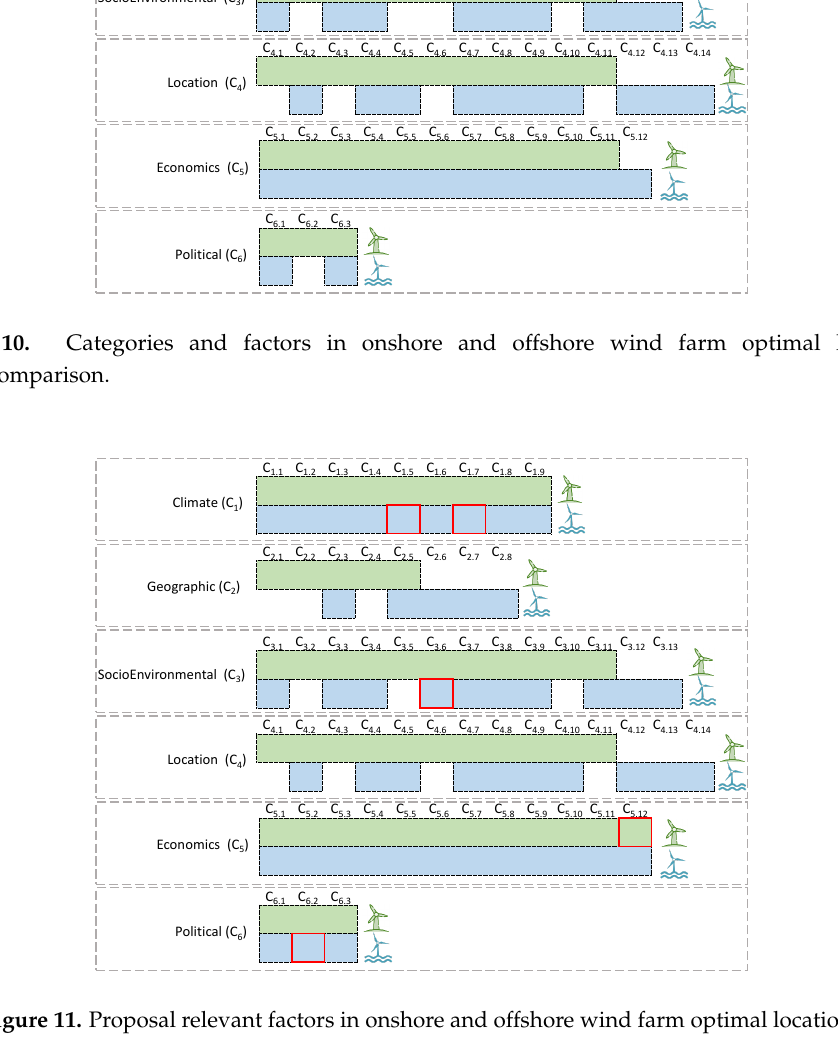
Figure 11. Proposal relevant factors in onshore and offshore wind farm optimal